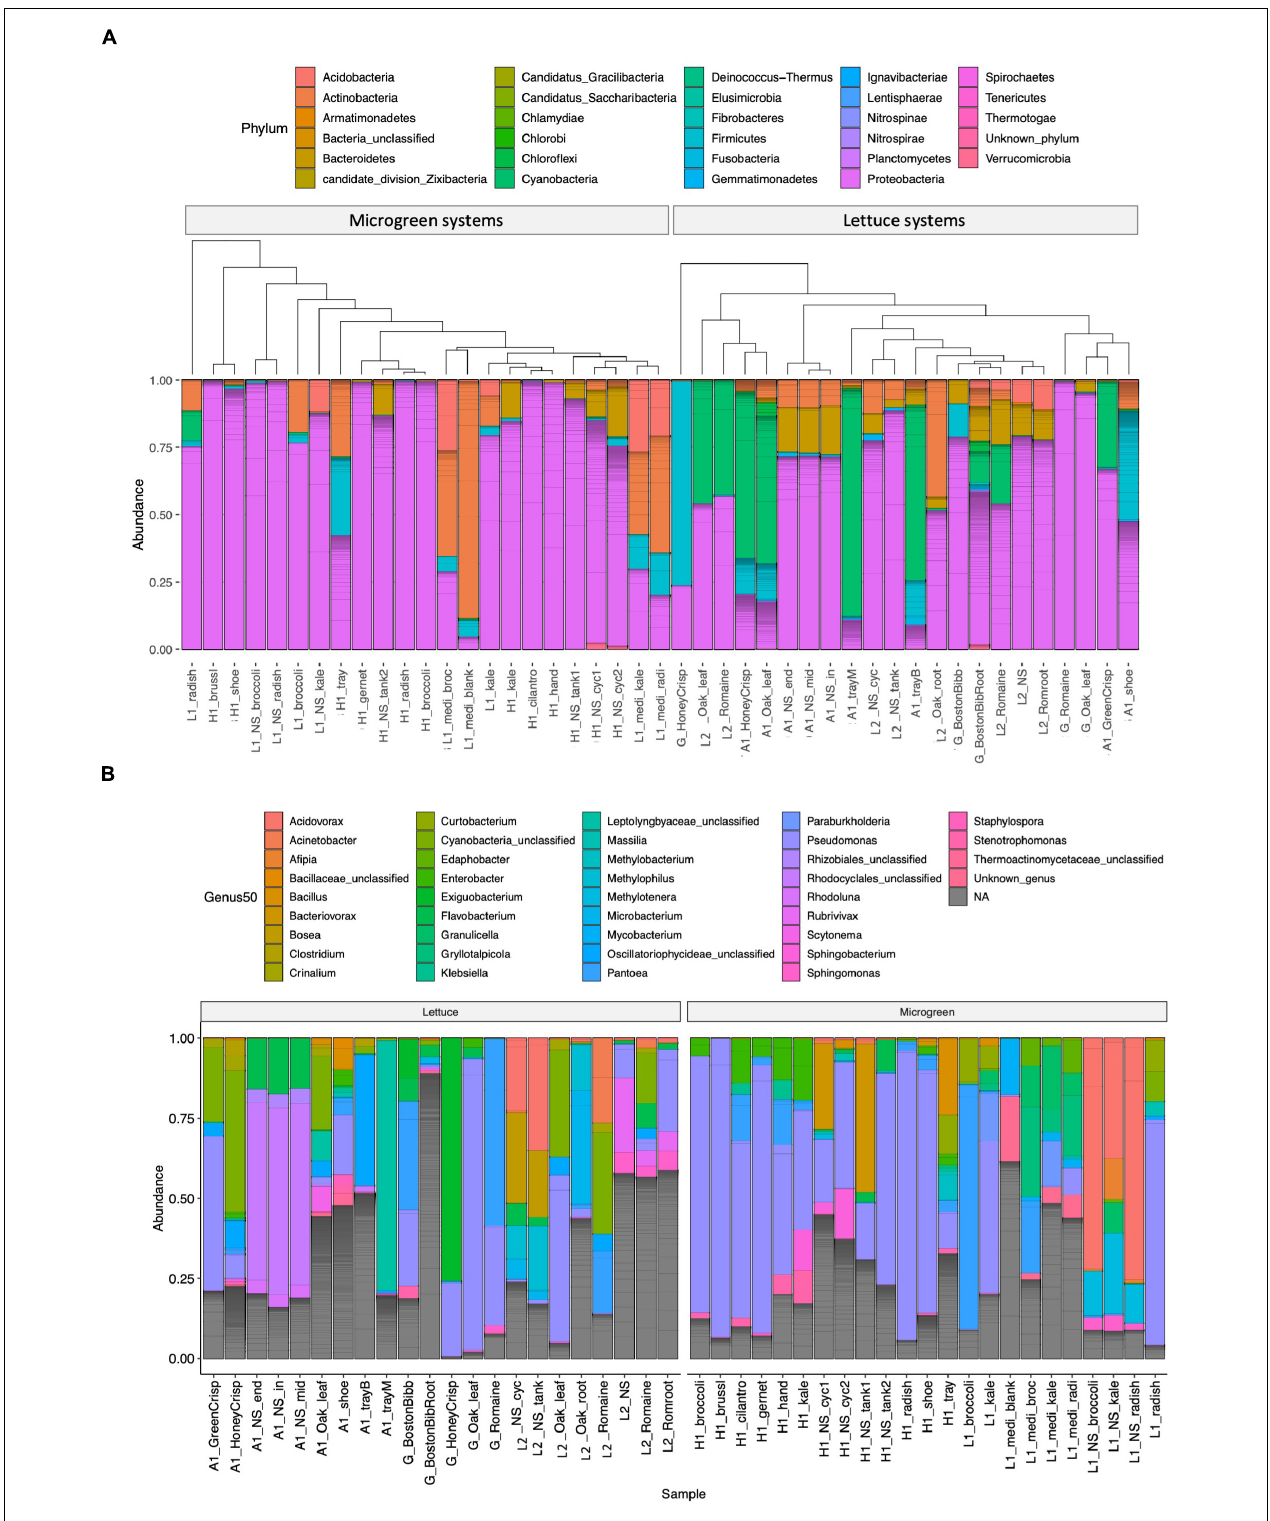
FIGURE 2 | Microbiome compositions. (A) Phylum-level composition: samples are grouped by microgreen (left) or lettuce (right) systems. The samples are clustered by microbiome similarity using the phylogenetic tree structures. (B) Genus-level classification of the 50 most abundant ASVs parted by system type of lettuce (left) or microgreen (right). Individual ASVs are separated by a gray line within the bar